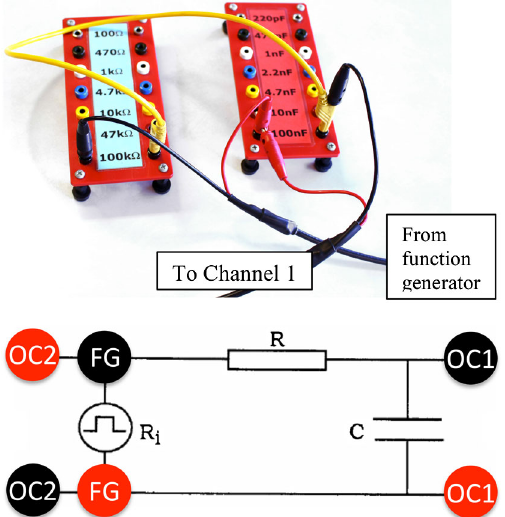
FIG. 6. A pictorial and a diagrammatic representation of the students ’ circuit after they had connected the oscilloscope ’ s channel 2 directly to the function generator. FG refers to the function generator and OC1 and OC2 refer to the oscilloscope ’ s channel 1 and channel 2, respectively. As pointed out earlier, the OC2 connections took place by default through the use of the BNC T connector (see Fig. 5).